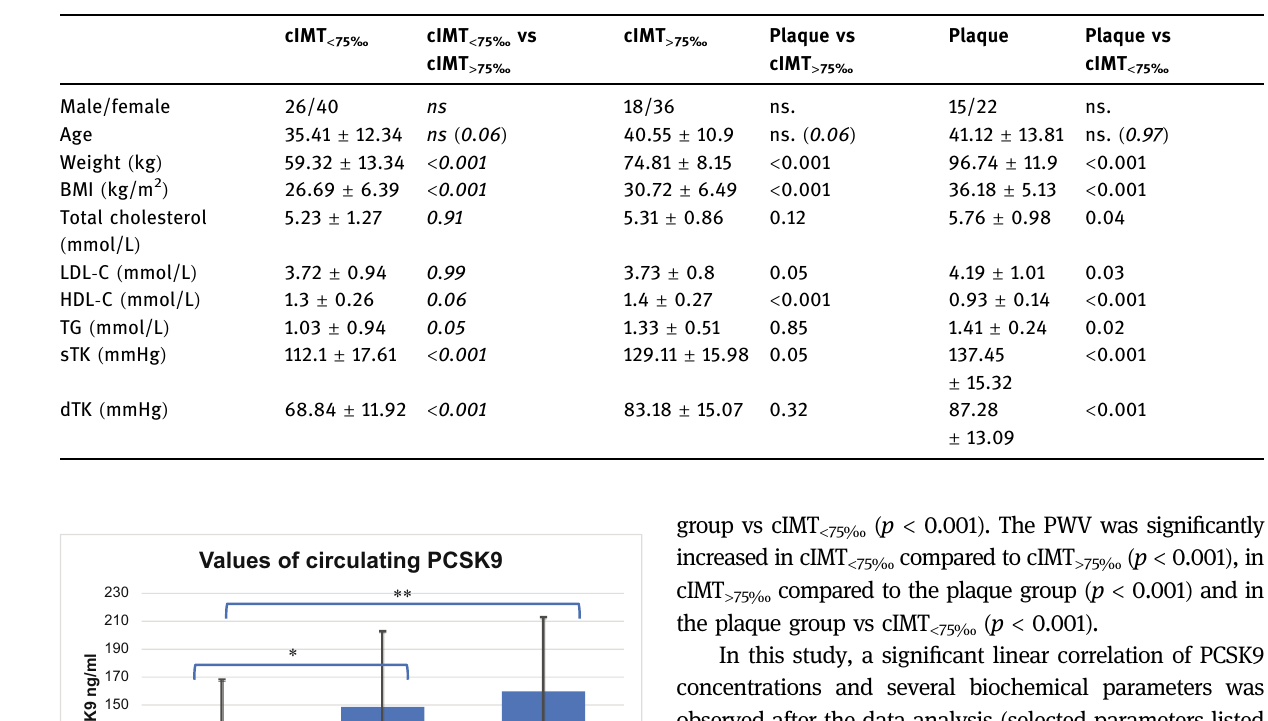
Table 1: Baseline characteristics of subjects